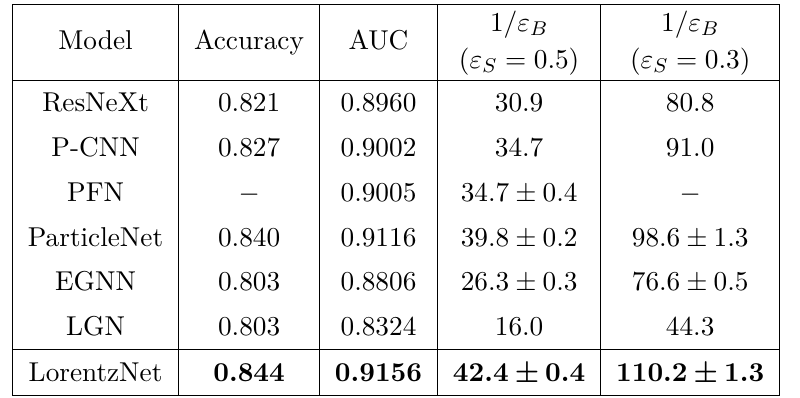
Table 2 . Performance comparison between LorentzNet and other representative algorithms on quark-gluon tagging dataset. The results for LorentzNet, EGNN and LGN are averaged on 6 runs. The results for other baselines are referred to [36,